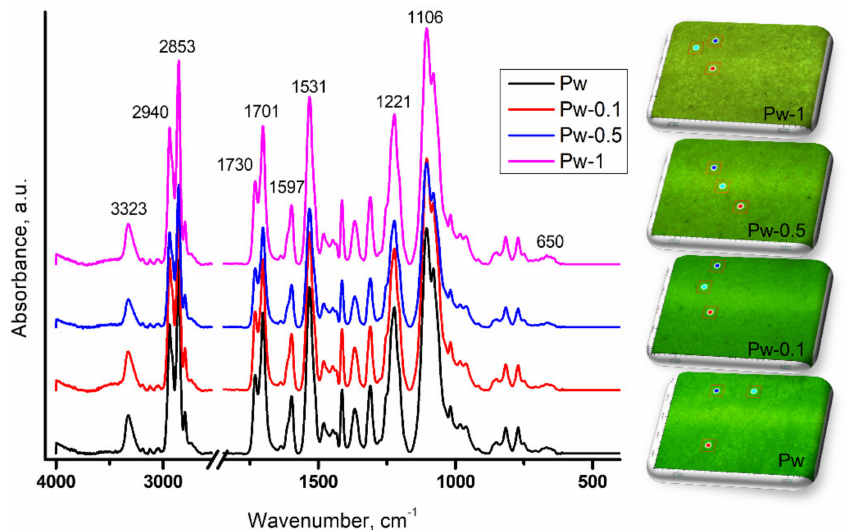
Figure 9. ATR-FTIR and corresponding microscope images of PU-based composite membranes prepared in wet conditions with different amounts of